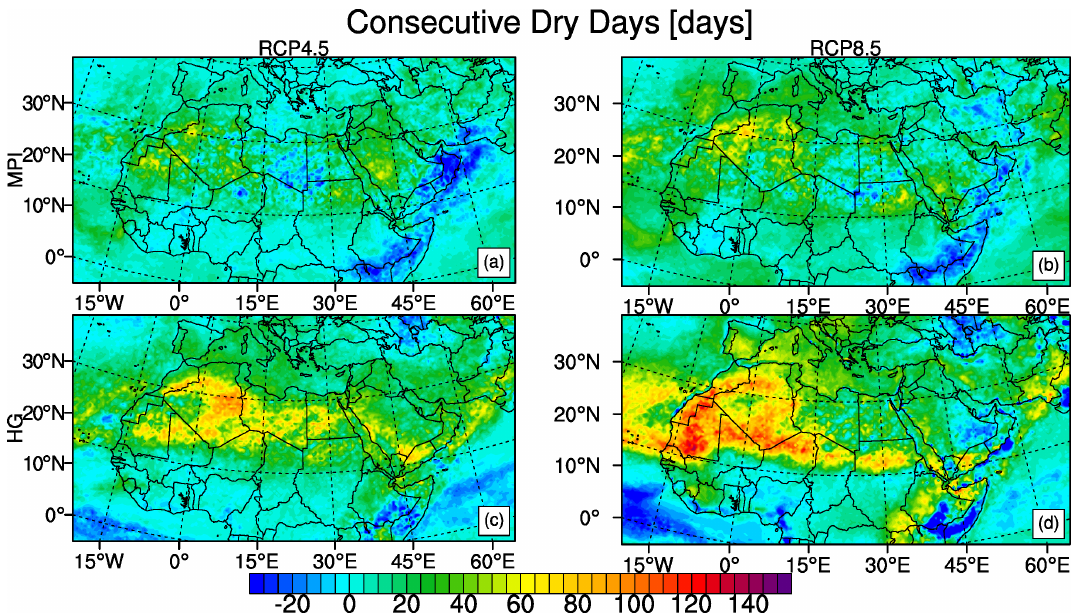
Figure 12. The temporally averaged changes in the consecutive dry days for the period of 2071–2100 displayed as differences (in days) with respect to the reference period 1971–2000 for the model MPI-ESM-MR with RCP4.5 ( a ) and RCP8.5 ( b ) and for the model HadGEM2-ES with RCP4.5 ( c ) and RCP8.5 ( d